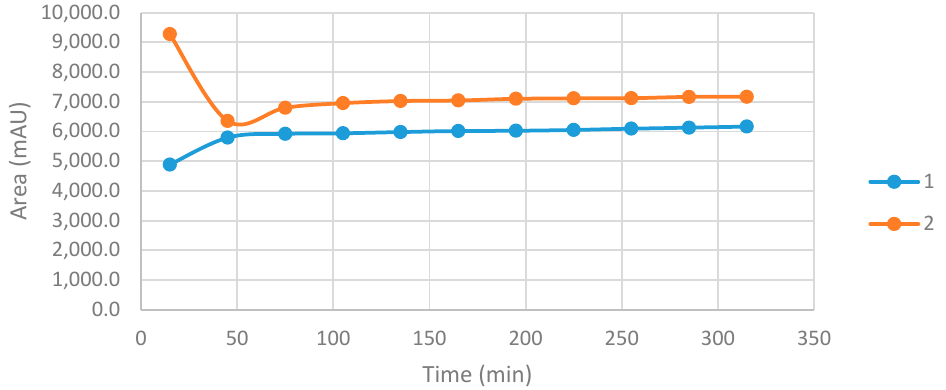
Figure 5. Change in the chromatographic peak area of adduct 1 of chalcones 1 and 2 in the chalcone– NAC incubations at pH 8.0/8.5.